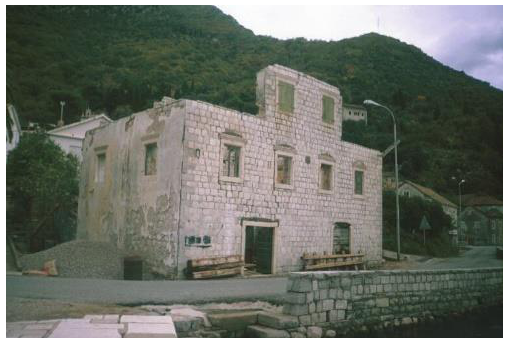
Figure 30. Captain’s house dating from 1842, before and at the beginning of reconstruction. Figure 31. Captain’s house dating from 1842, before and at the beginning of reconstruction.